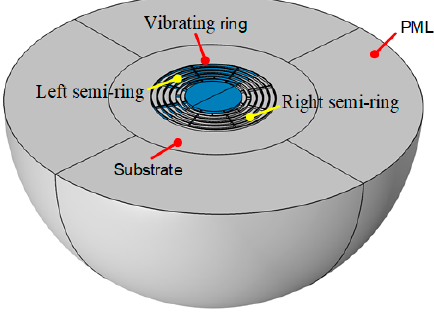
Figure 5. Anchor loss model for the DRG.